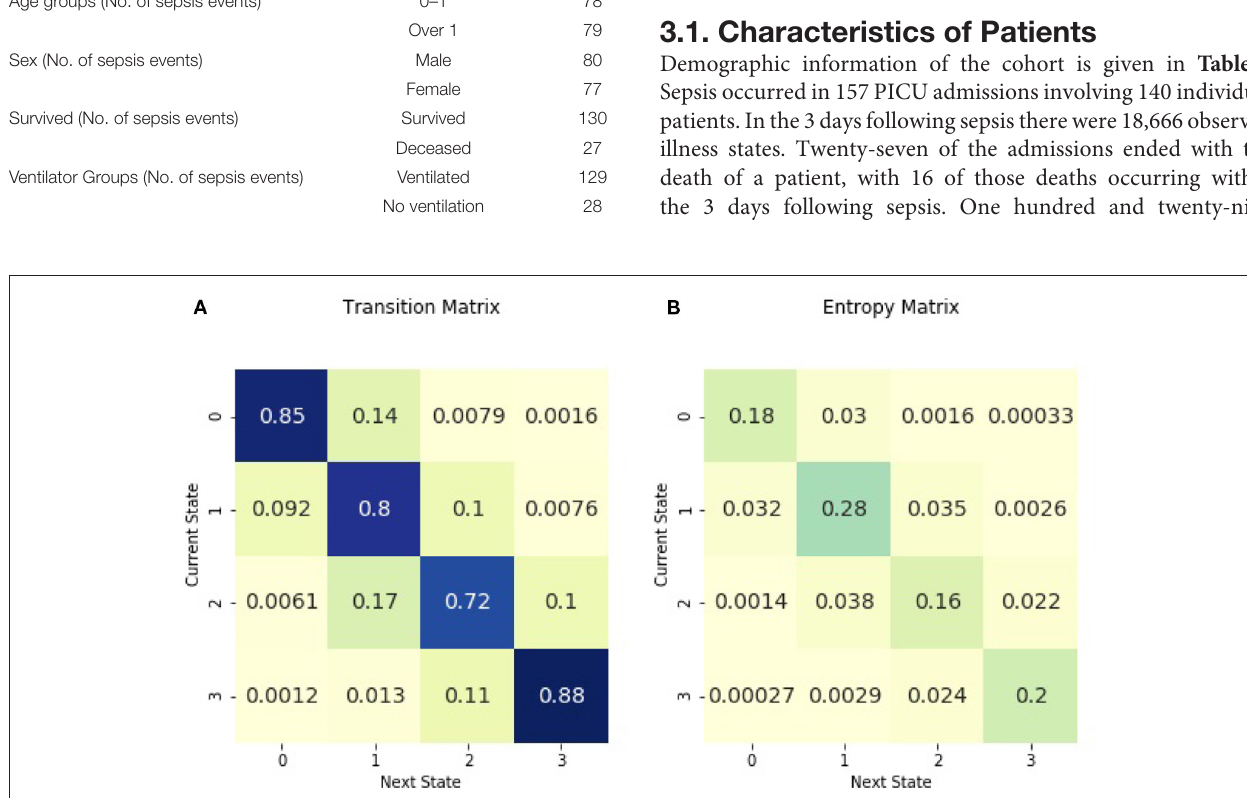
Frontiers in Pediatrics |